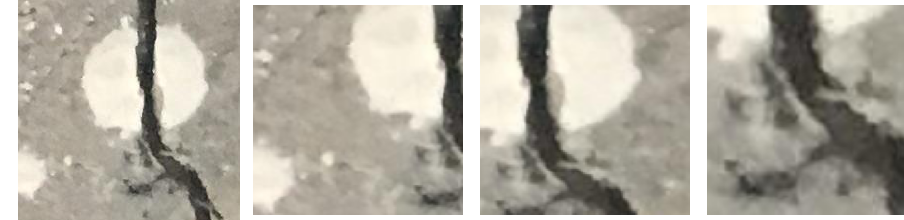
Figure 3. Example of Random Resized Crop transformation. (Left is the original image).